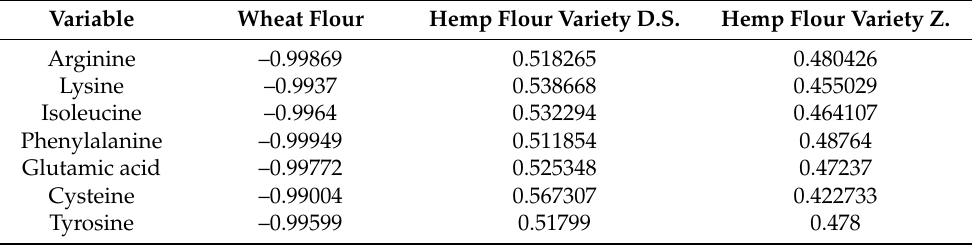
Table 9. The content of carbohydrates of wheat flour and hemp flour. Samples (g/100 g) Sucrose Glucose Fructose Wheat Flour